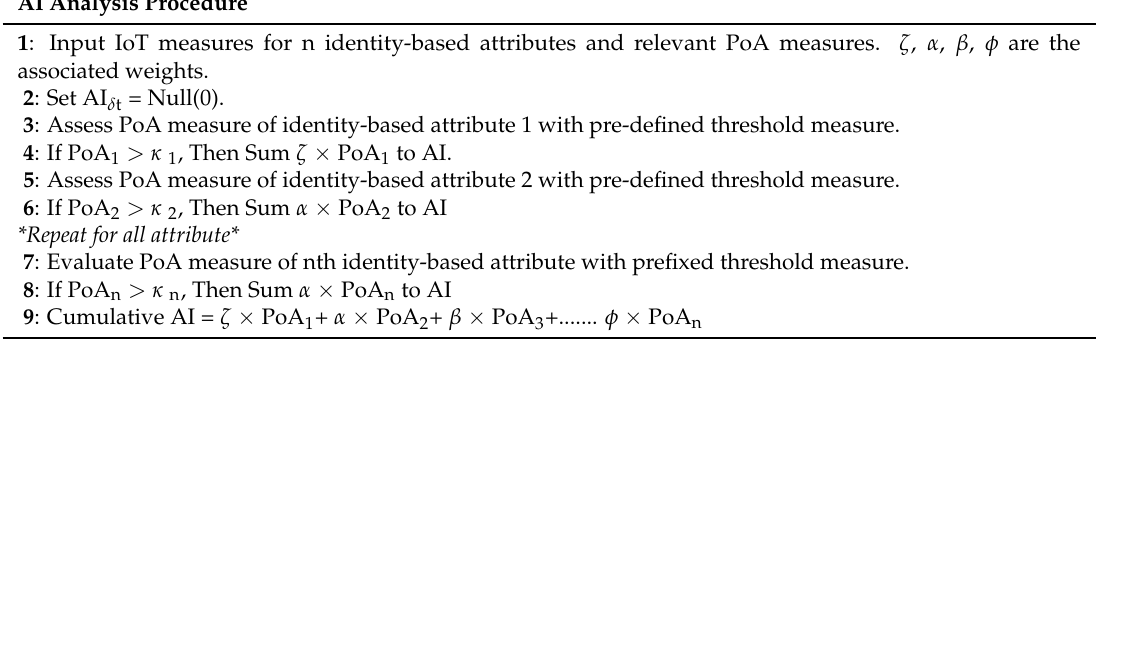
Table 2. Identity AI Analysis Procedure